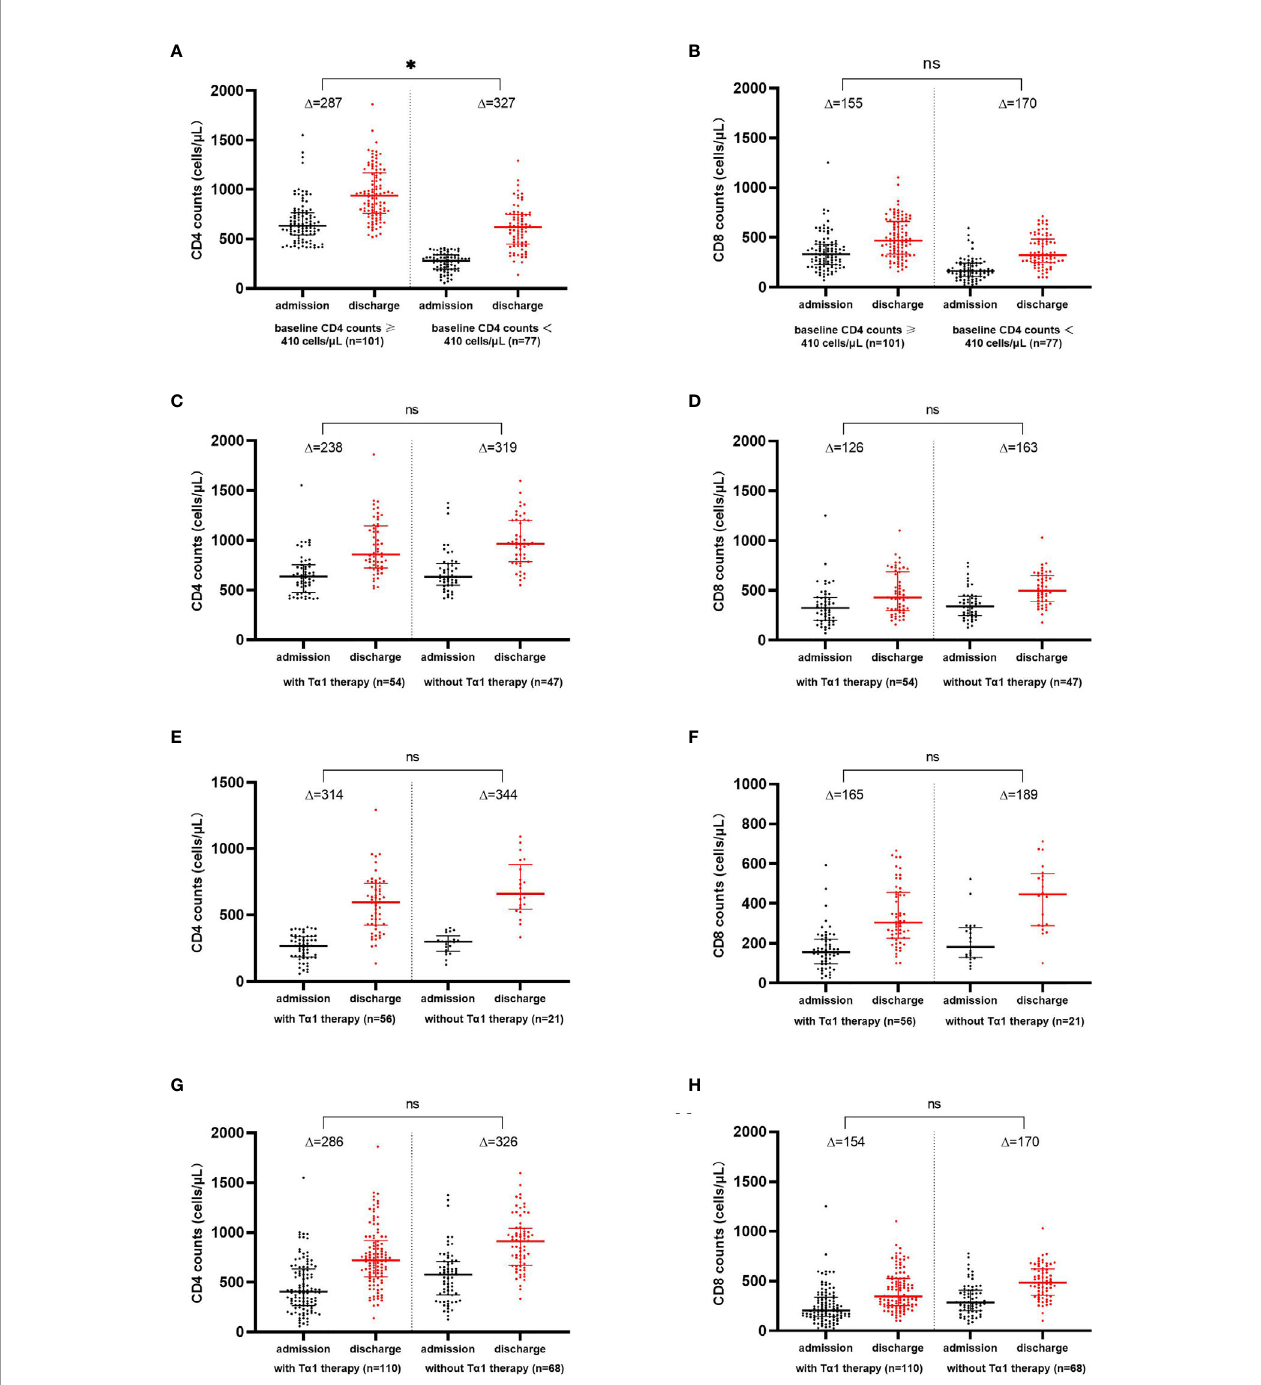
FIGURE 1 | CD4+ and CD8+ T-lymphocytes counts increased from baseline during the convalescence of COVID-19. Changes of CD4+ and CD8+ T cell counts in COVID-19 patients with baseline CD4 counts ≥ 410 cells/ m L and<410 cells/ m L (A, B) , with normal baseline CD4 counts (C, D) , with decreased baseline CD4 counts (E, F) , and with or without T a 1 therapy (G, H) . * p<0.05; ns, no signi fi